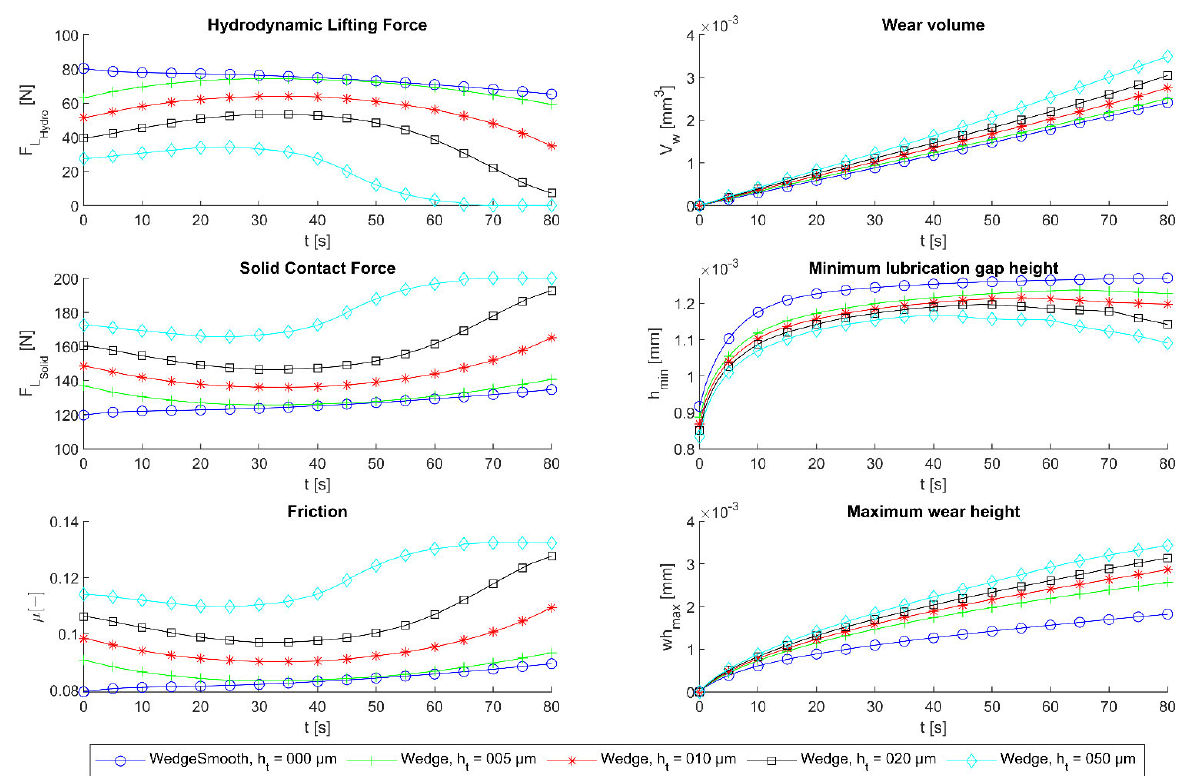
Figure 7. Development of the selected tribosystem parameters as a function of time in mixed friction and the associated wear.